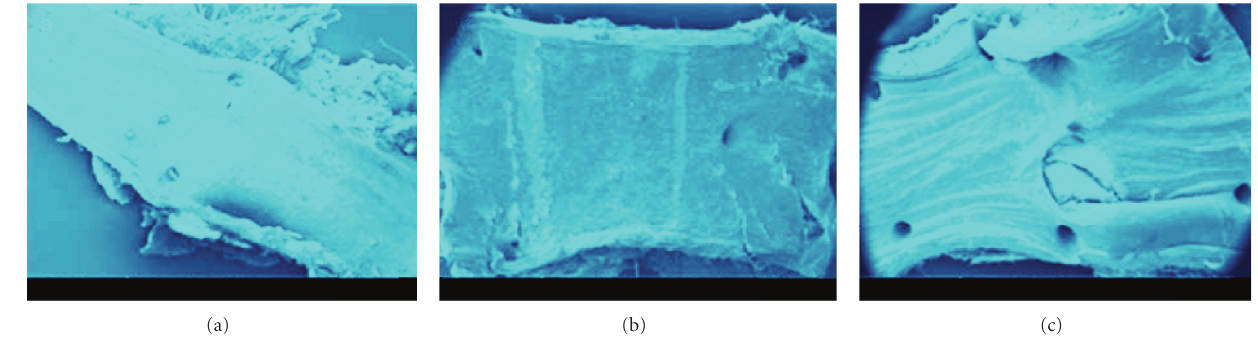
Figure 25: SEM (magnification 169 × to 199 × ): (a) untreated segment of the carotid artery, (b) and (c) good endothelialization of nanocellulose grafts [222].